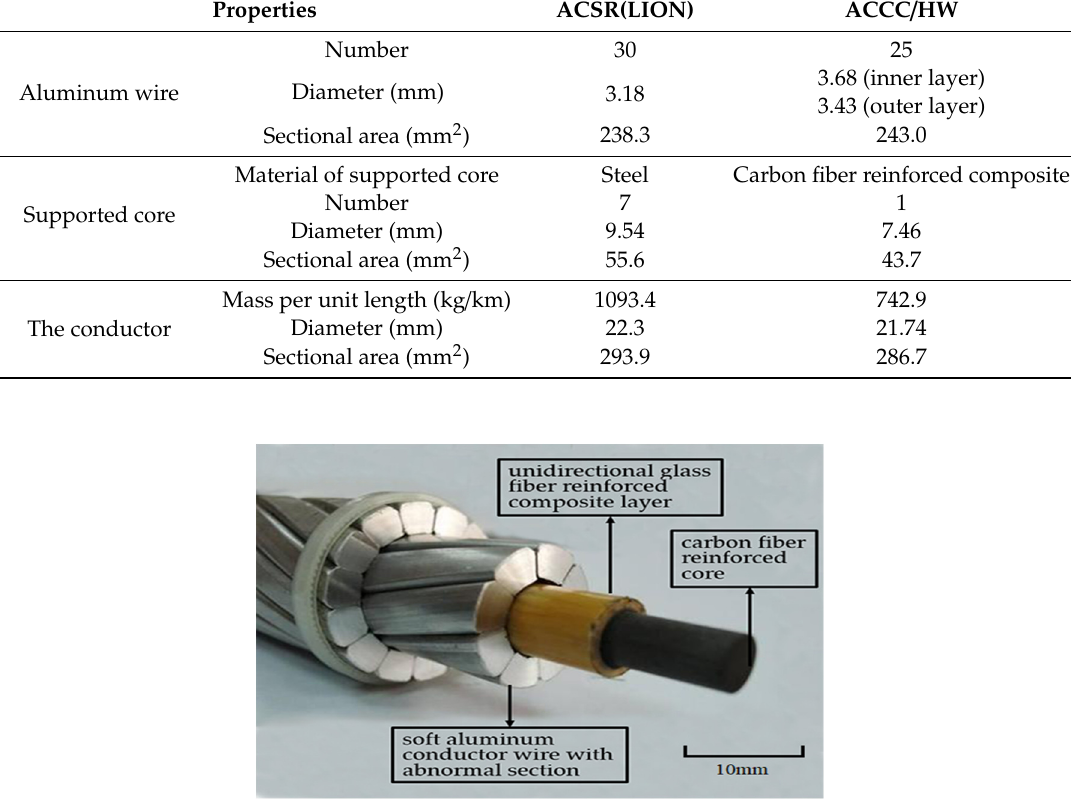
Figure 3. Conductor configuration of carbon/glass hybrid fiber reinforced epoxy resin composite and T-type soft aluminum wires (ACCC/TW).